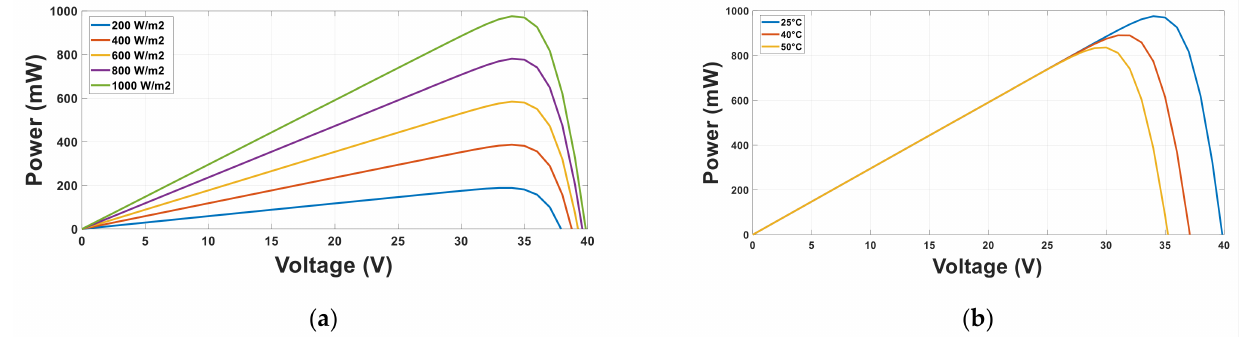
Figure 9. ( a ) Effect of radiation intensity effect on the P-V characteristics of single-junction GaAs solar cells. ( b ) Temperature effect on the P-V curve of single-junction GaAs PV cells under AM 1.5 condition.